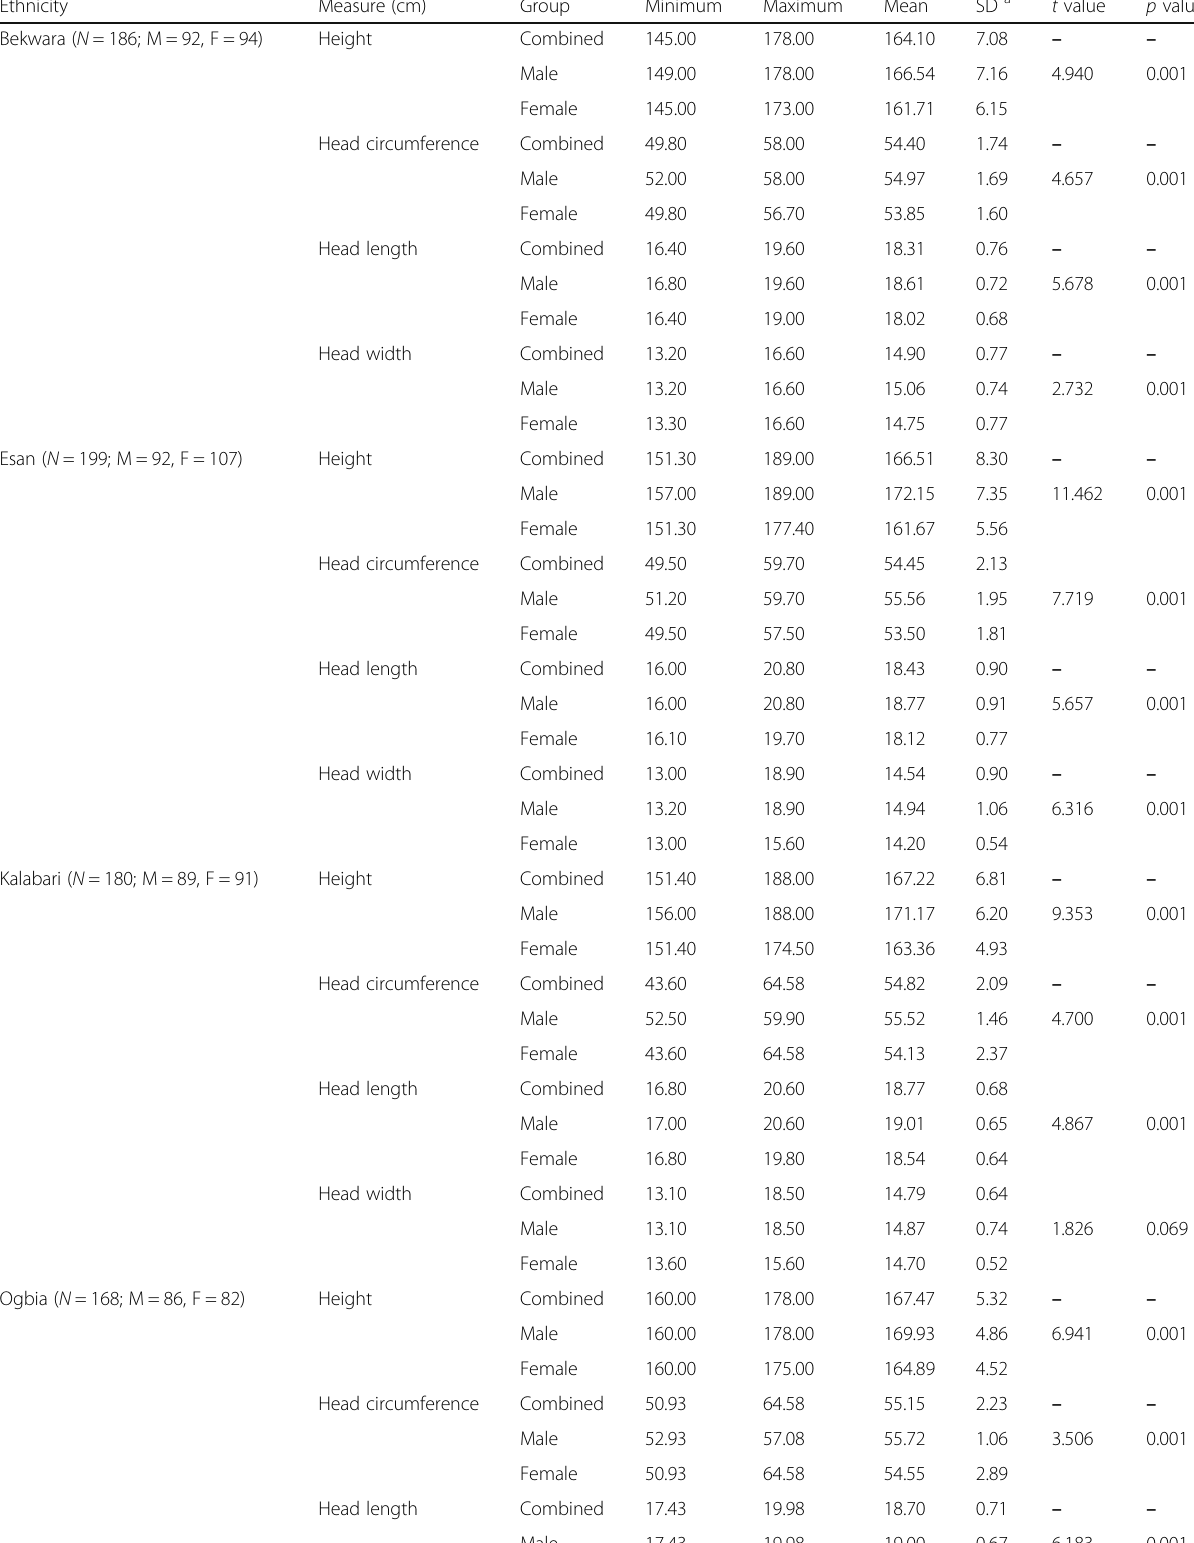
Table 1 Comparison of measured parameters between males and females in the five ethnic groups Ethnicity Measure (cm) Group Minimum Bekwara ( N = 186; M = 92, F =